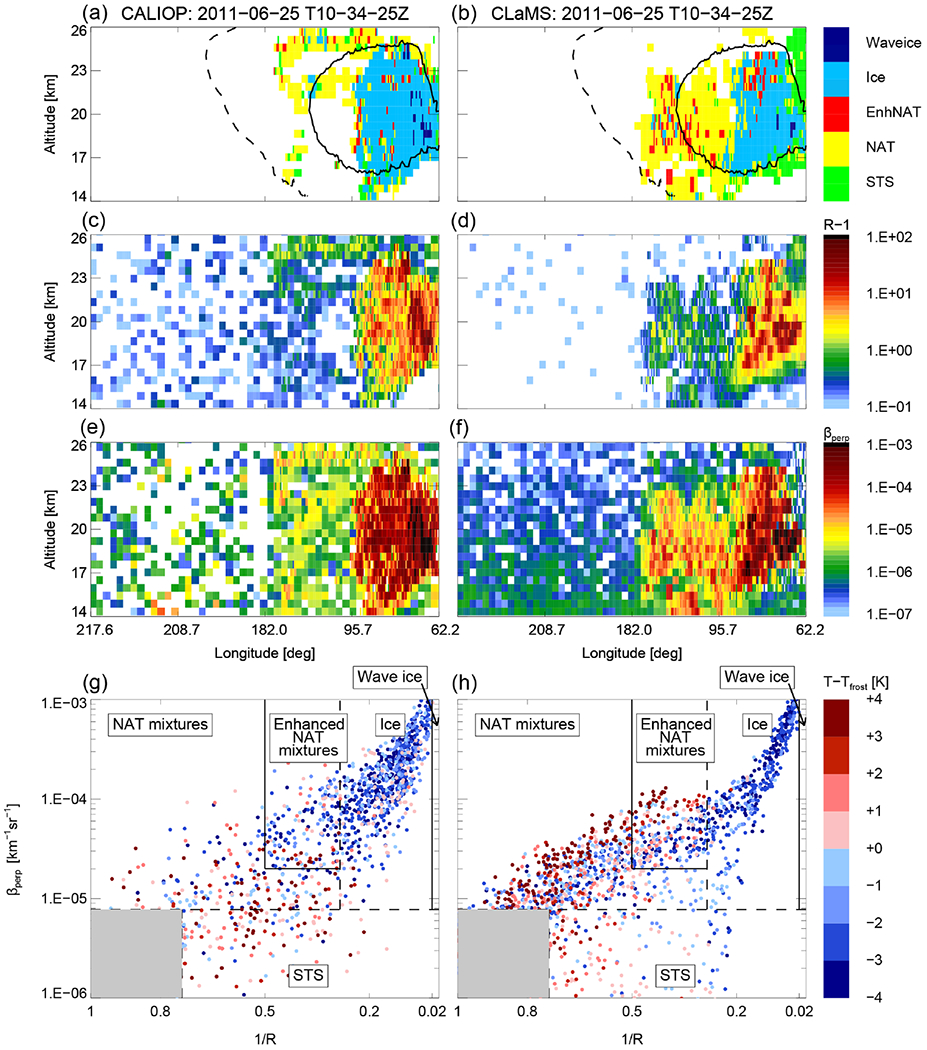
Same as Fig. 3 but for 25 June 2011: CALIPSO orbit track 2011-06-25T10-34-25Z.